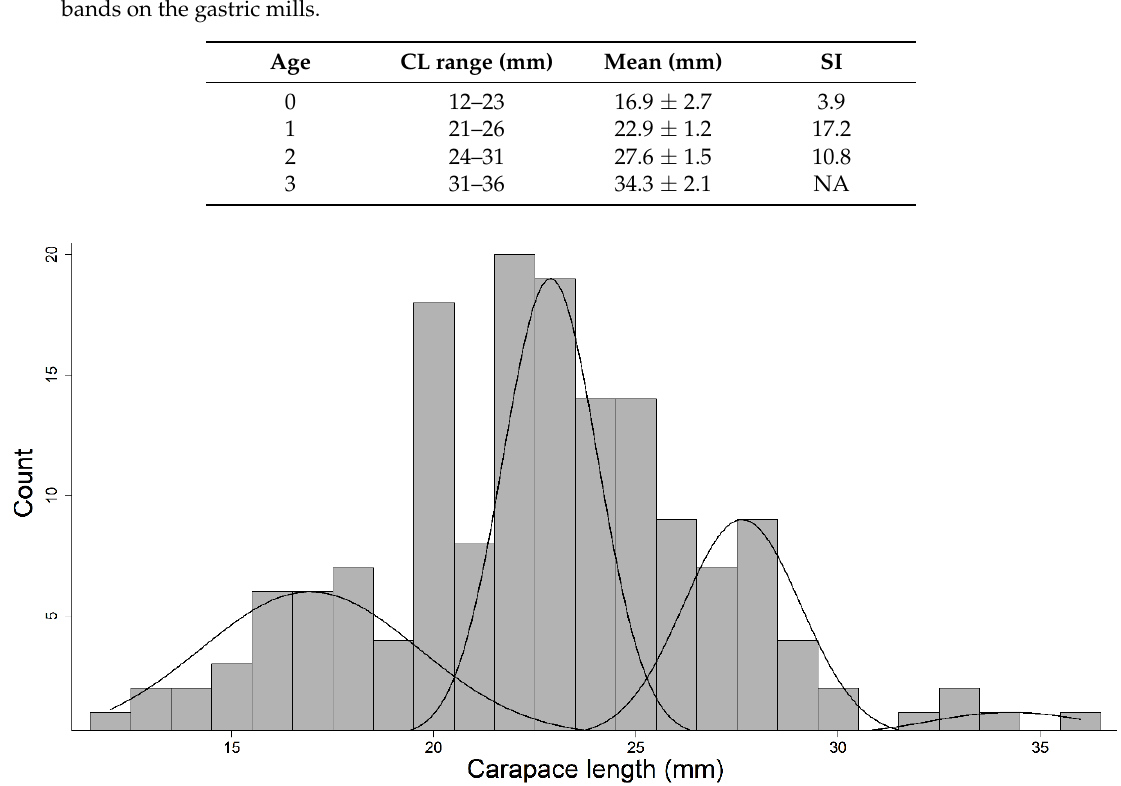
Figure 7. Length-frequency histogram of gapped ringed crayfish Faxonius neglectus chaenodactylus collected from Big Creek near the confluence of Tumbling Creek. Crayfish were collected via seining and hand searching and collection. The black curves represent age classes determined via the Bhattacharya method.